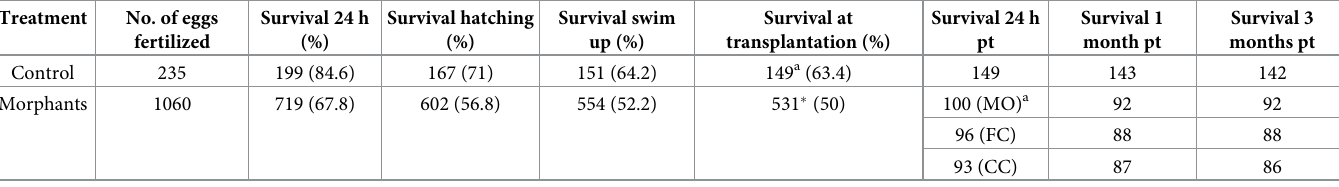
Table 2. Recipient goldfish survival during the experiment. Treatment